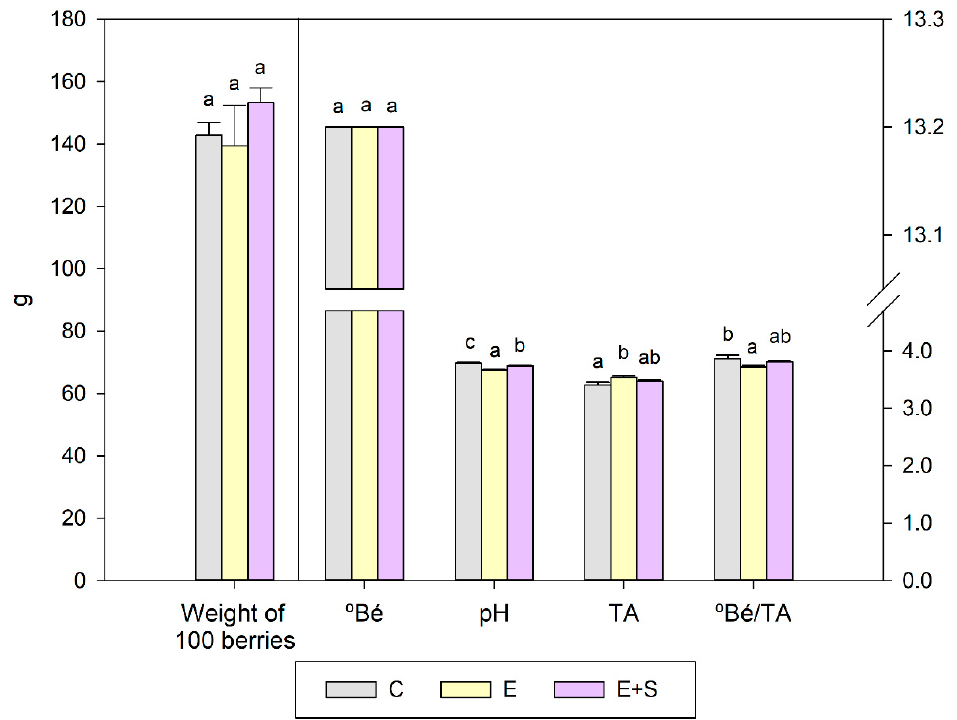
Figure 2. Enological parameters determined in Bobal grapes on harvest day. C: control grapevines (untreated); E: grapevines treated by endotherapy; E + S: grapevines treated by endotherapy and spraying. Left y -axis: weight of 100 berries (g). Right y -axis: °Bé (Baumé degrees); pH; TA (titratable acidity expressed as g/L of tartaric acid); °Bé/TA. All data are expressed as mean ± SD ( n = 4). For each parameter, different letters indicate significant differences according to the Tukey test ( p < 0.05).